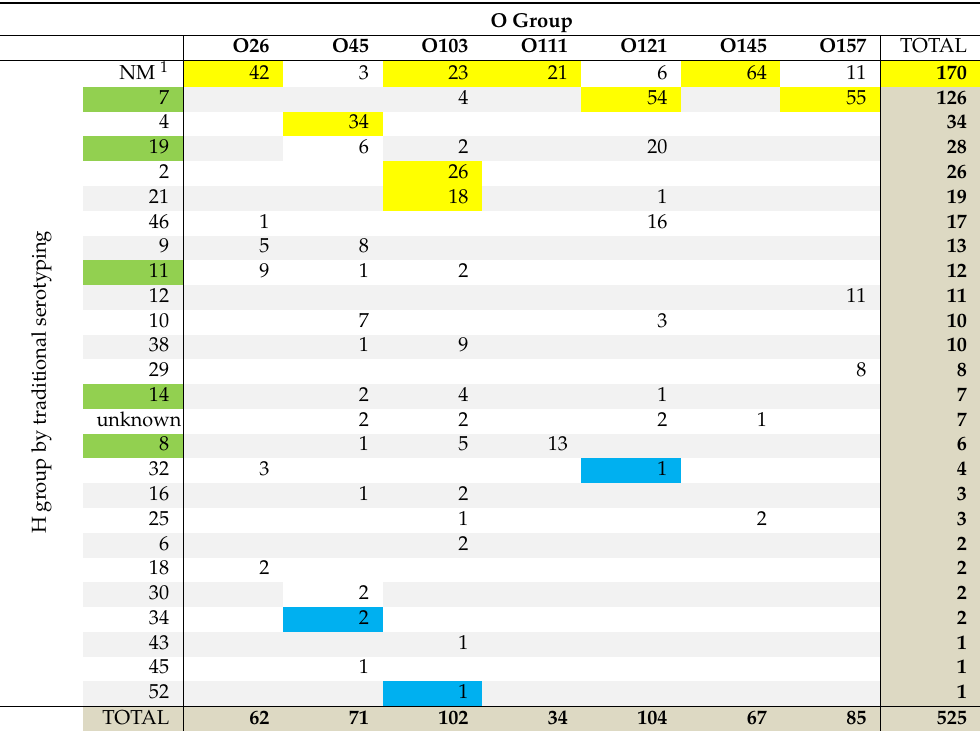
Table 2. Numbers of Top 7 isolates of each serotype including only those where PCR and traditional serotyping determined the same O group ( n =